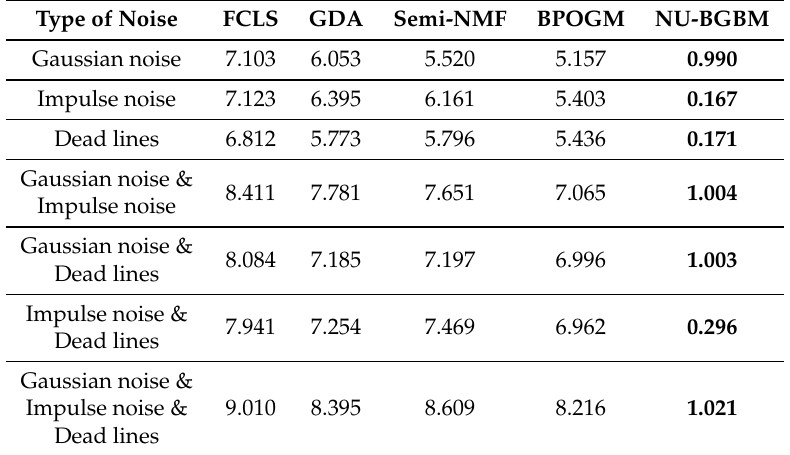
Table 1. Comparison of RMSEs ( × 10 − 2 ) for different methods in the presence of different types of noise.